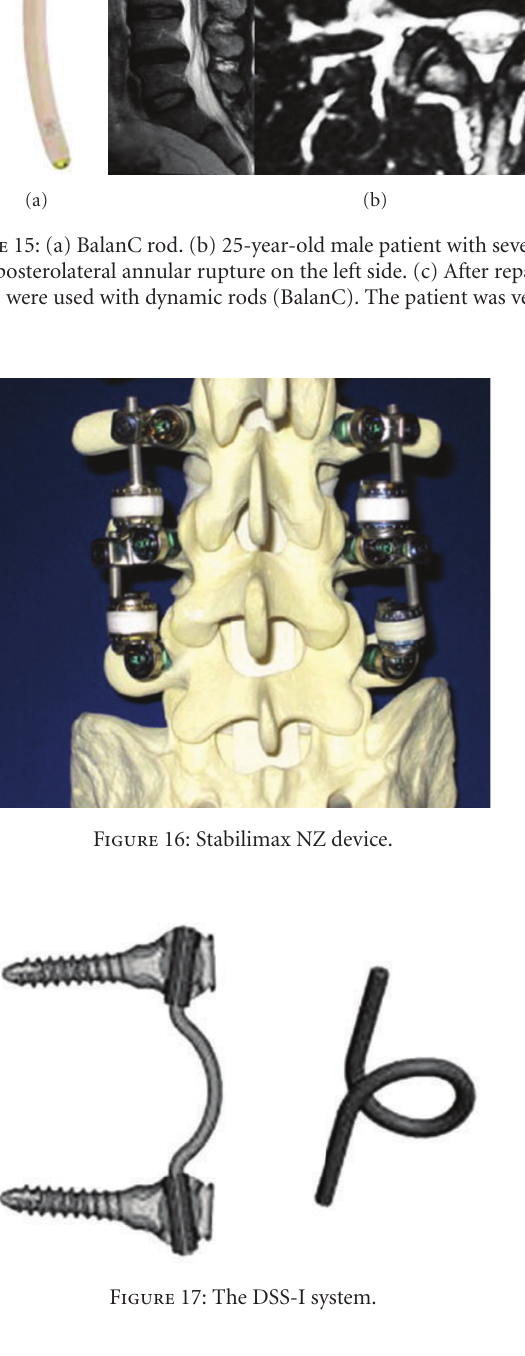
(Figure 21) (X-Stop, St. Francis Medical Technologies,